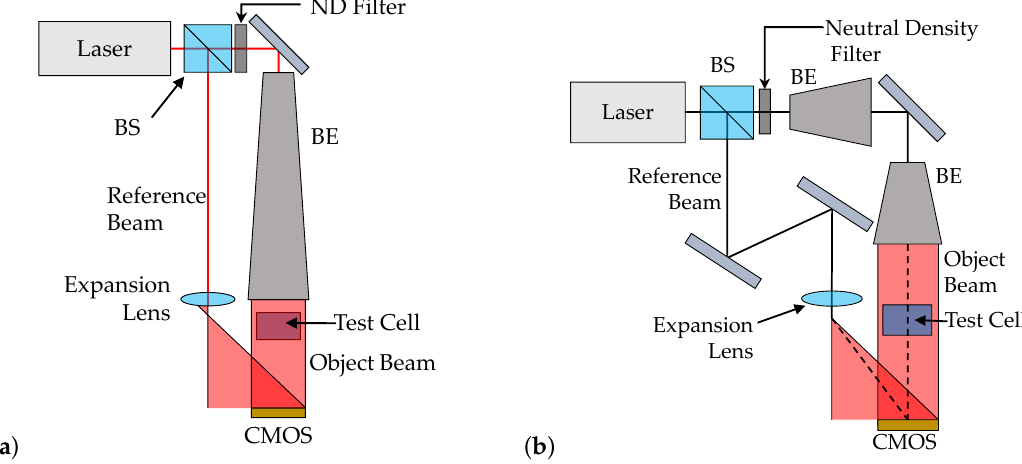
Figure 6. ( a ) Schematic of the FRED model of a dosimeter with equalised beamlines. ( b ) Schematic of the FRED model of the miniaturised